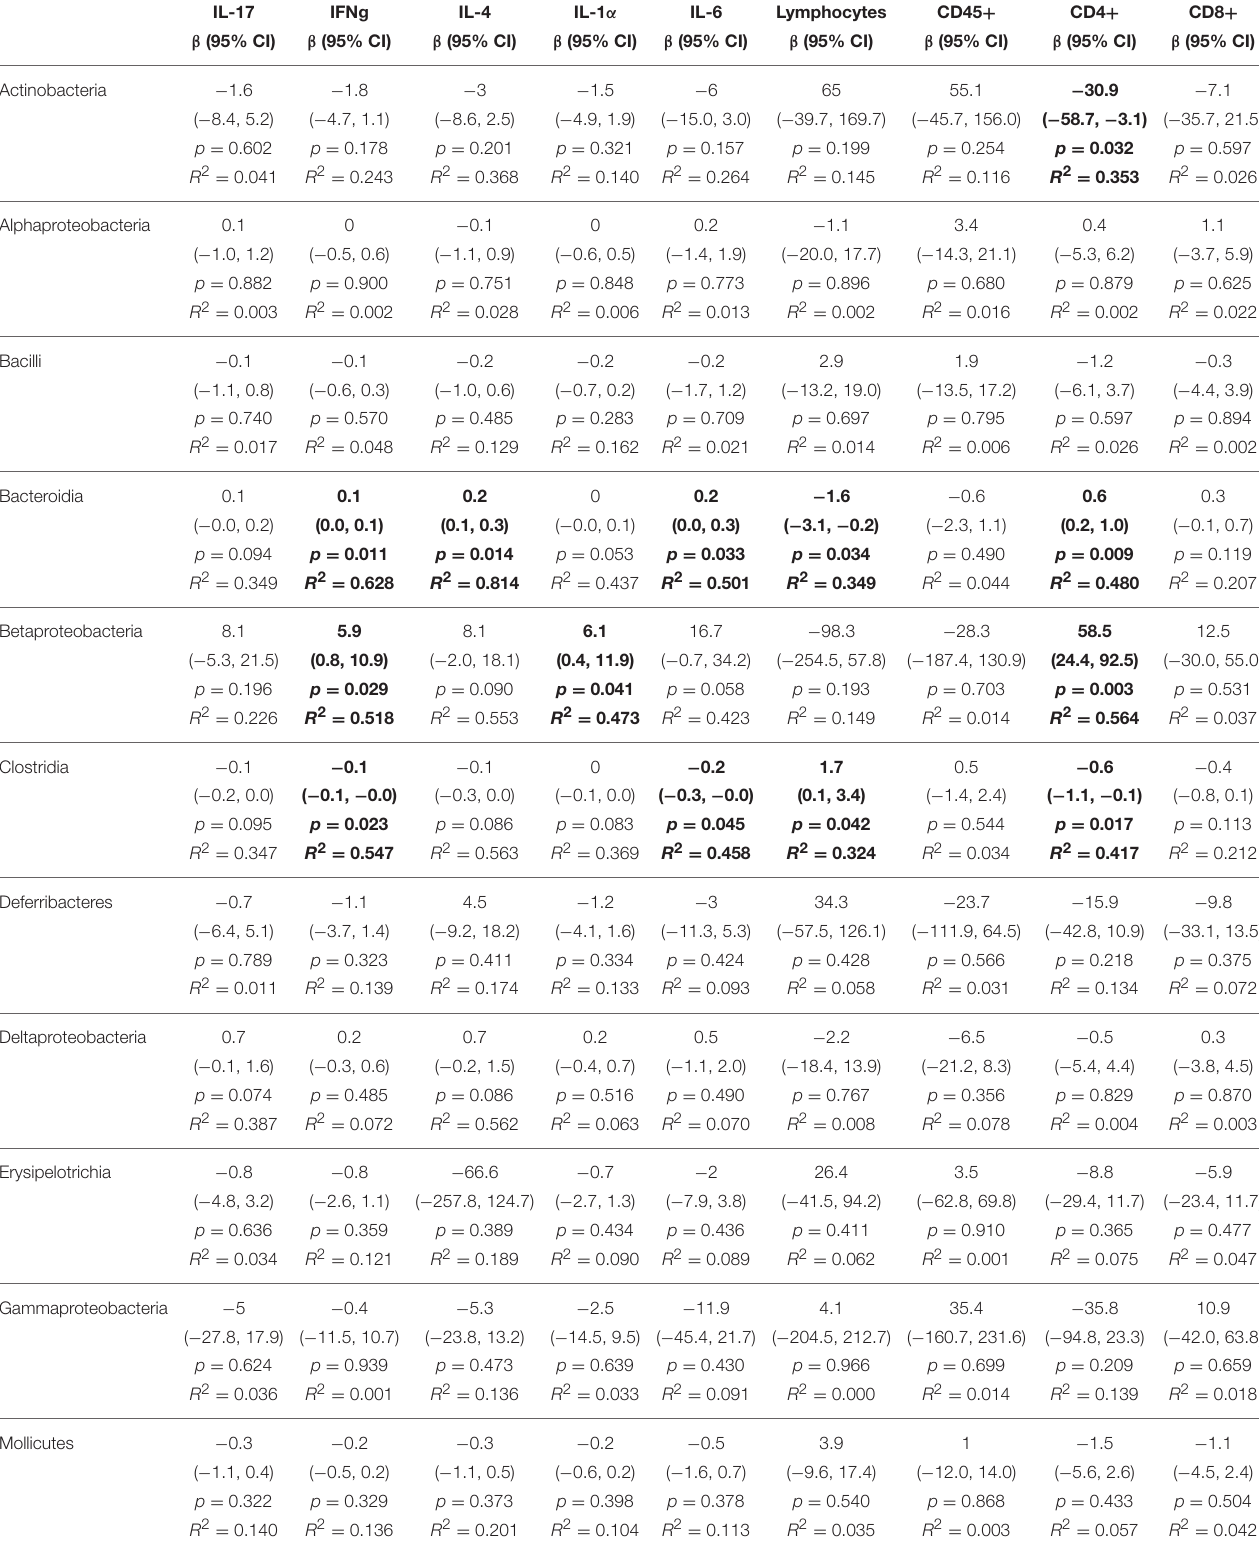
TABLE 2 | Associations from linear regression models between gut microbiota and alterations of adaptive immune system parameters measured in the